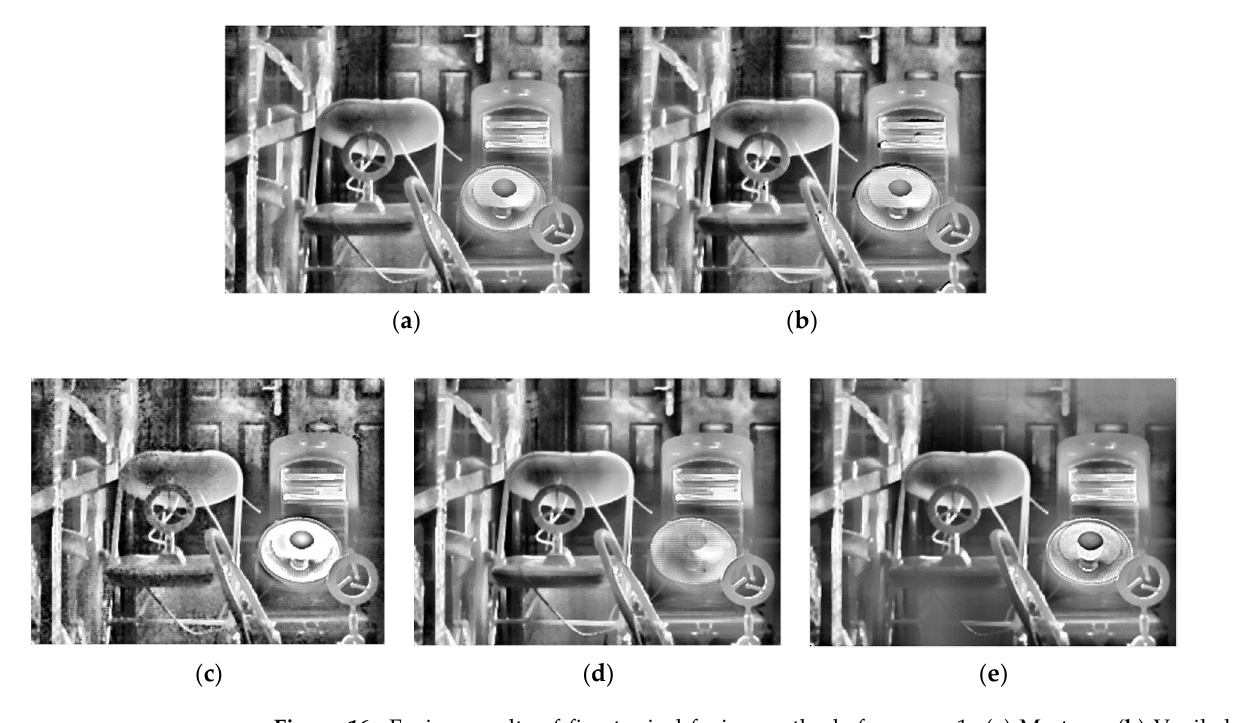
Figure 16. Fusion results of five typical fusion methods for scene 1: ( a ) Mertens; ( b ) Vonikakis; ( c ) Ma; ( d ) Kou; ( e ) MIF&DE.